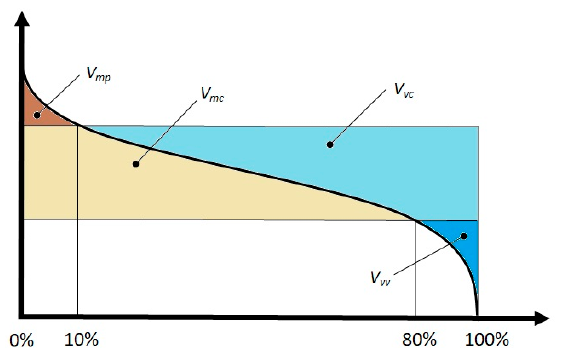
Figure 1. Graphical representation of the volume parameters with respect to the Abbott–Firestone curve.